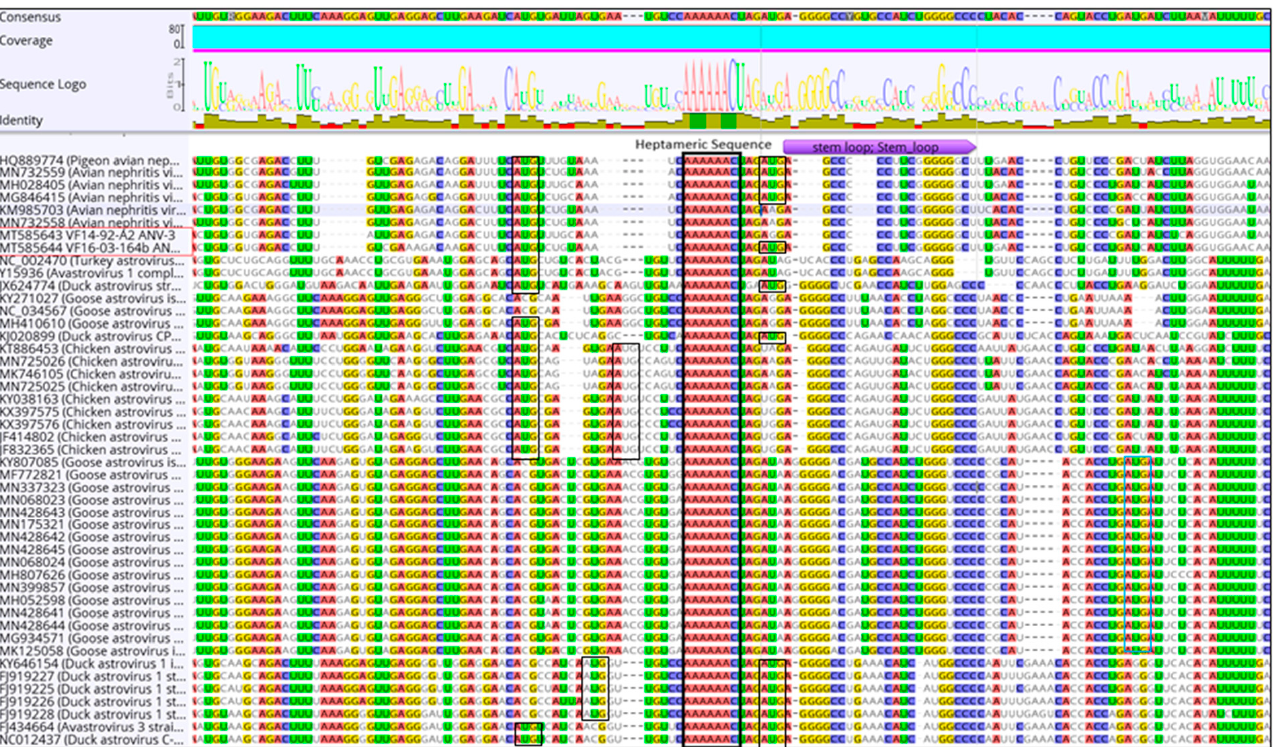
Figure 2. Astroviridae ribosomal frameshift mechanism ORF1a and ORF1b. Alignment of the Avastroviridae whole genome heptameric slippery sequence and stemloop region including ANV-3 strains and MT585643 VF14-92-A2 and MT585644 VF16-03-164b. Red box is ANV VF14-92-A2 and VF16-03-64b, blue box and * identify the methionine/putative start codons, and the black box marks the heptameric slippery sequence.